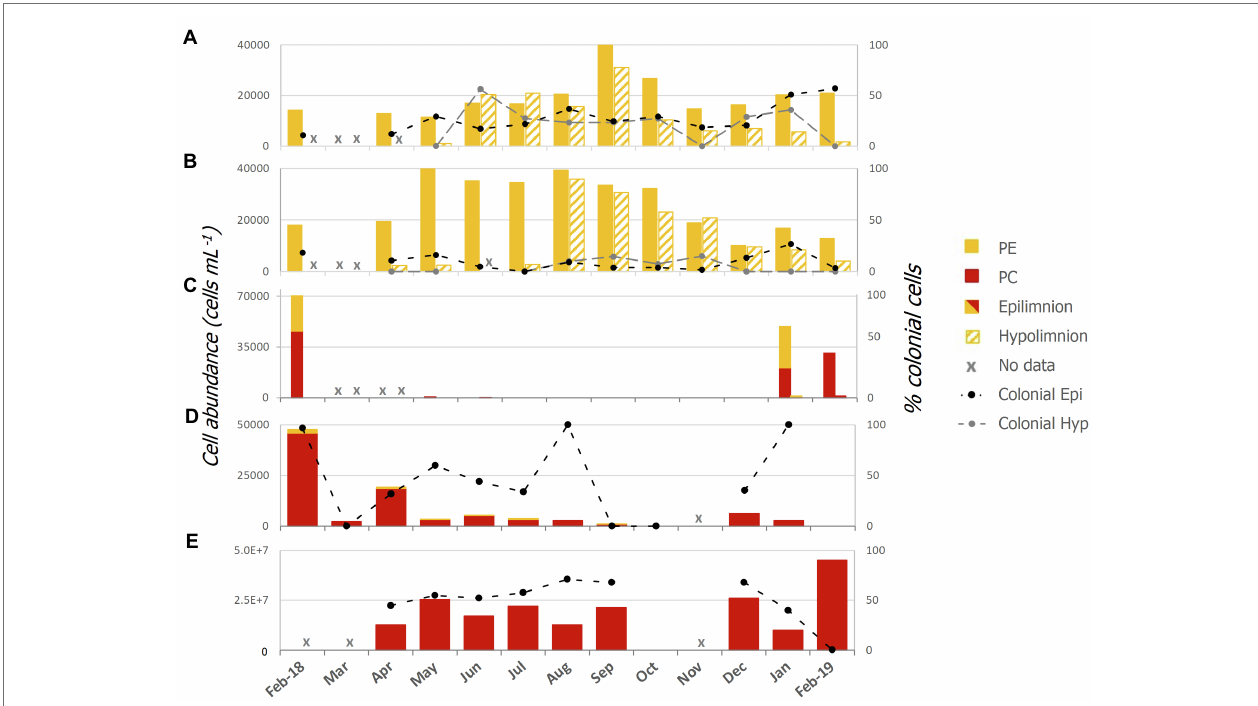
FIGURE 2 | Picocyanobacterial abundances from February 2018 to February 2019 in lakes; (A) Wanaka, (B) Wakatipu, (C) Hayes, (D) Tomahawk Lagoon, and (E) Ellesmere/Te Waihora as determined using epifluorescence microscopy. Colonial cells (as a percentage of the total cell count) are indicated by the black and grey thatched lines and secondary axis. Red bars represent phycocyanin (PC) rich cells while yellow bars represent phycoerythrin (PE) rich cells. Epi, epilimnion and Hyp, hypolimnion.